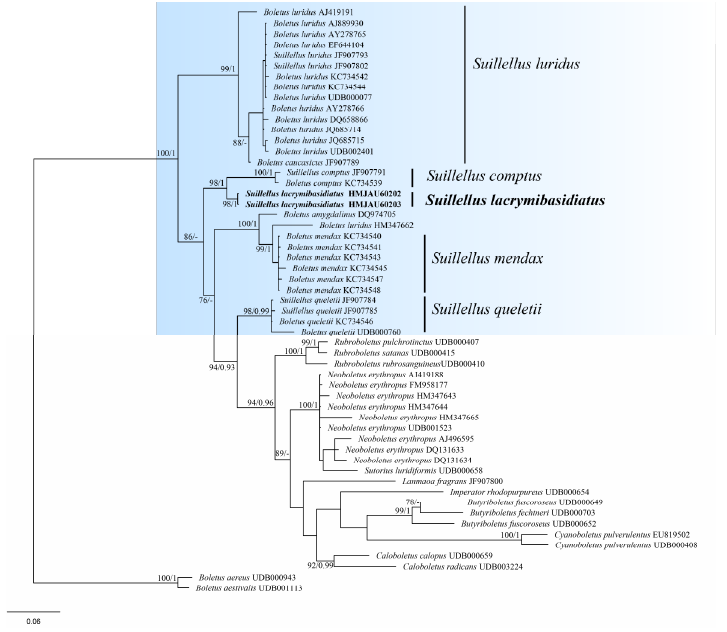
Figure 4. Phylogenetic analysis of Suillellus inferred from Bayes inference analysis based on ITS dataset. BP value (>70) and PP value (>9) are shown around branches. Our new species sequences are indicated in bold.